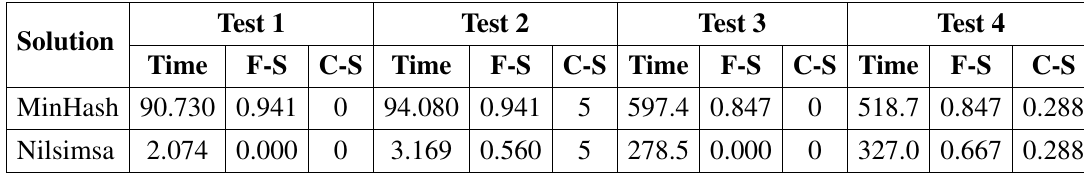
Table 4. Test results for LSH Functions MinHash and